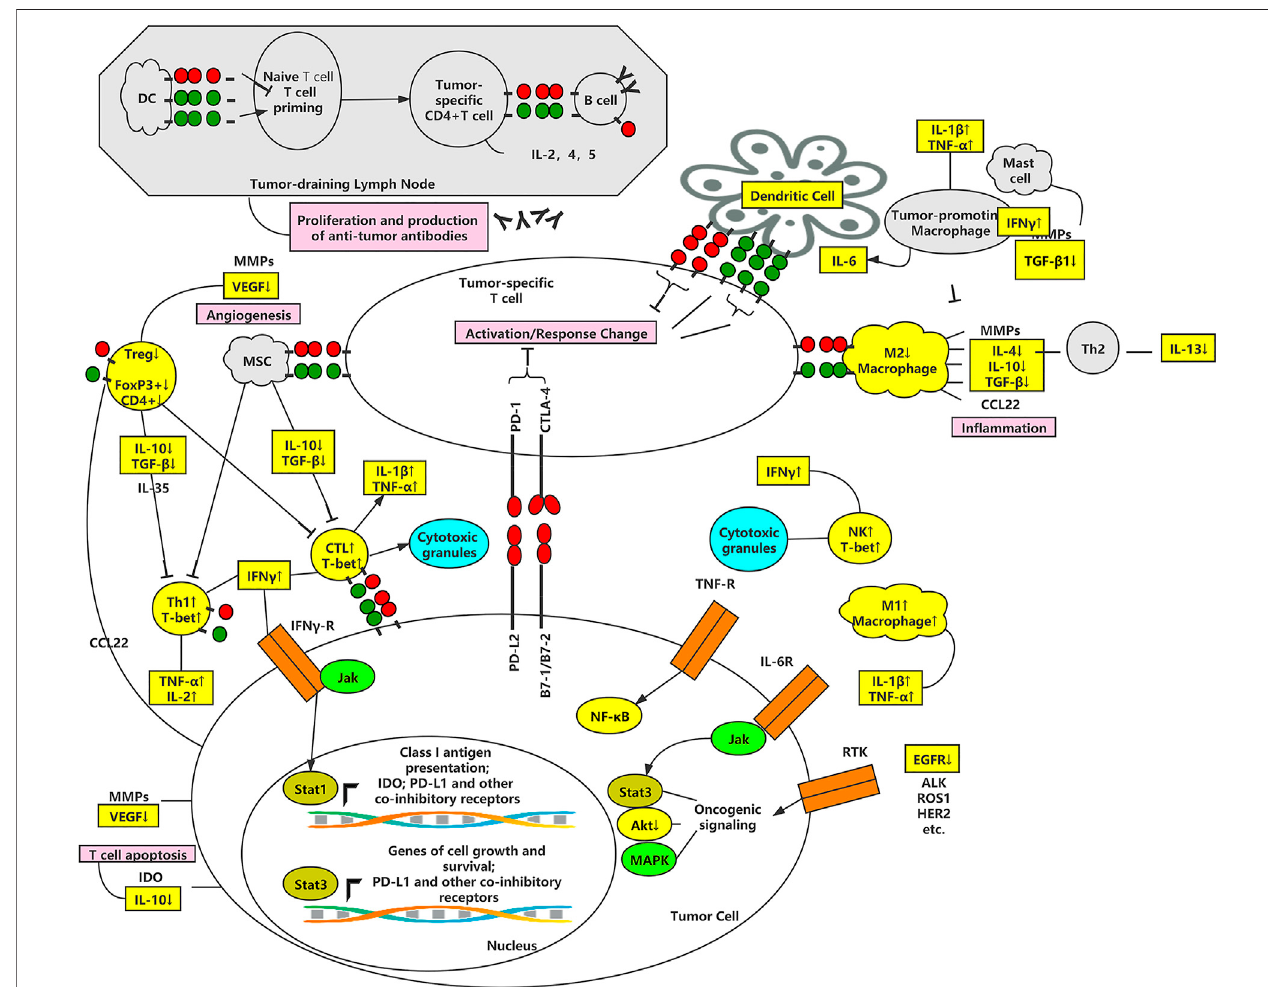
FIGURE 1 | The effect of APS on ICIs signaling pathway in